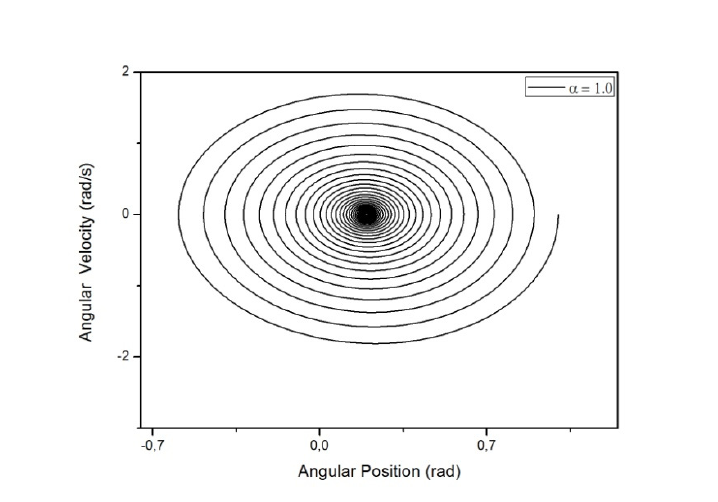
Figure 16. Pseudo-phase portrait (Case B for α = 0.9).